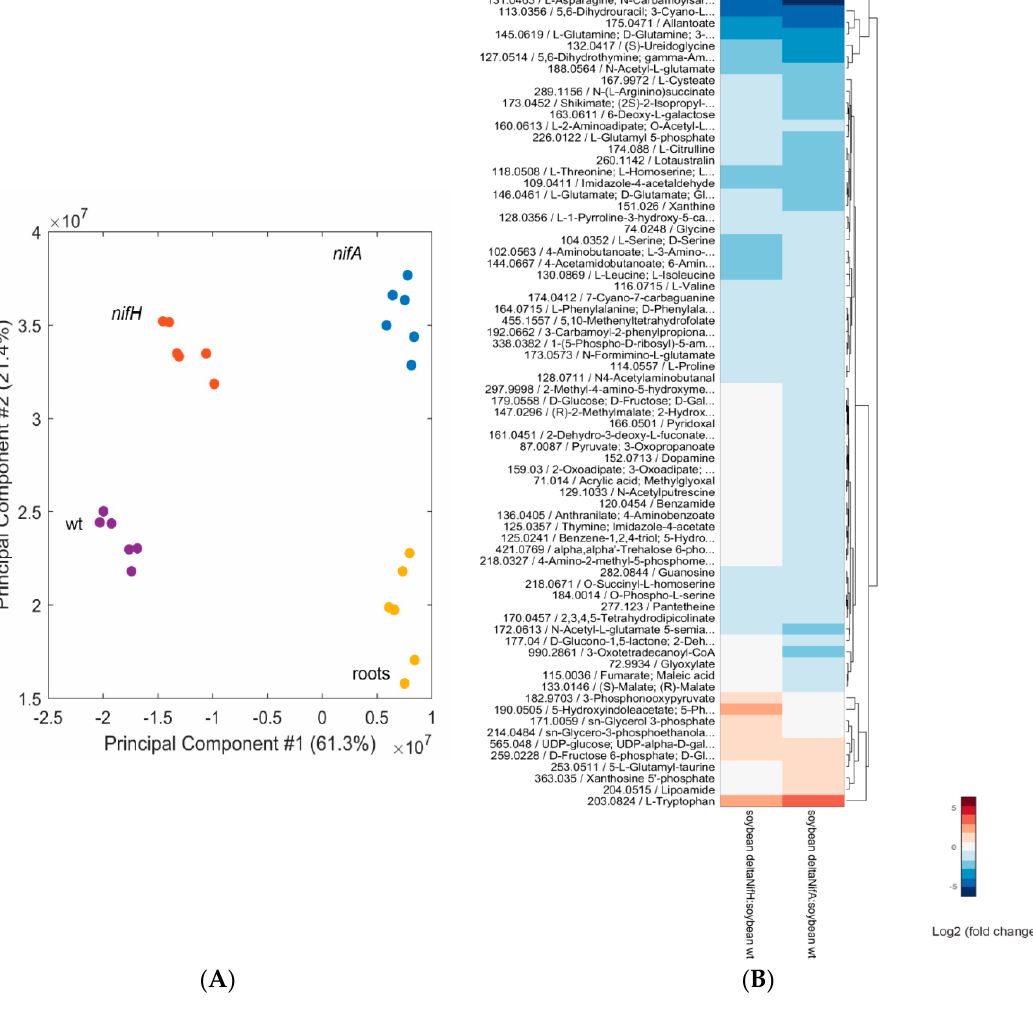
Figure 4. PCA of metabolite profiles from soybean wild-type nodules (purple), nifA nodules (blue), nifH nodules (orange) and soybean root only material (yellow) metabolite profiles; #: number ( A ). Three biological replicates were examined, each analyzed twice by non-targeted metabolomics.